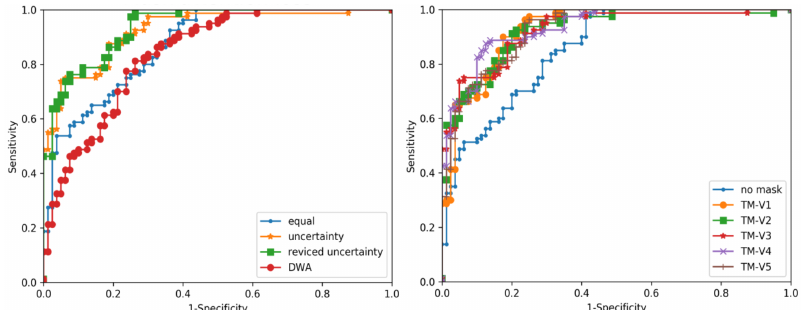
Figure 6. ROC curves of loss weight methods and template masks. ( Left ): Models using various ways to weigh multiple losses; ( Right ): Cases utilizing different characteristics for breast